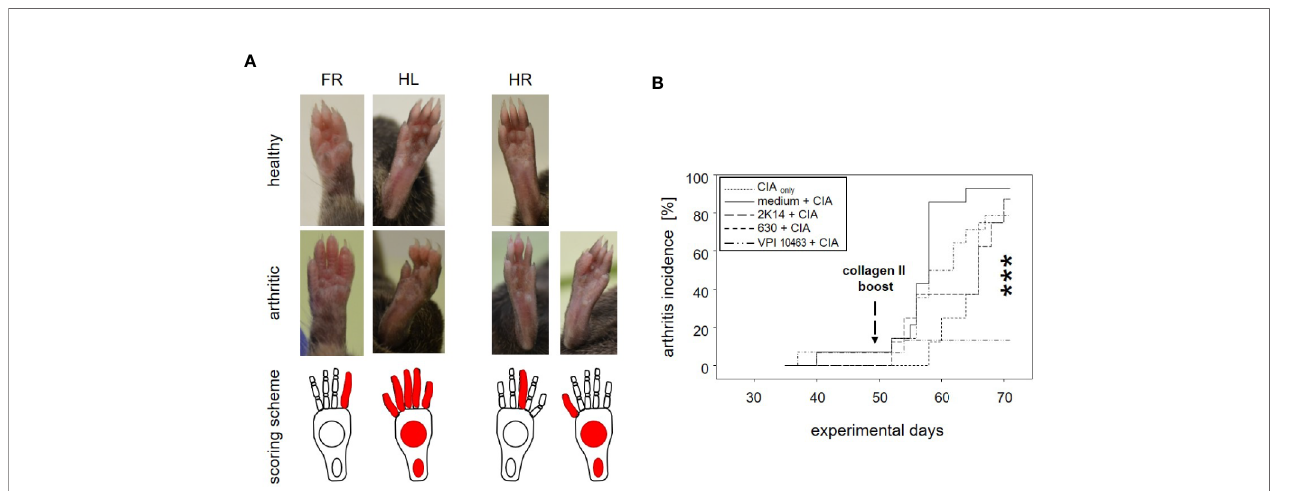
FIGURE 2 | Infection with Clostridioides dif fi cile signi fi cantly reduced incidence of collagen-induced arthritis in DBA/1J × B10.Q mice. (A) Macroscopic pictures of healthy (upper row) and arthritic paws (middle row) and corresponding scoring schemes (lower row) are shown. Middle row from left to right: an arthritis score of 1 (one in fl amed digit), 15 ( fi ve in fl amed digits, in fl amed tarsal and metatarsal joints), 1 (one in fl amed digit), and 11 (one in fl amed digit, in fl amed tarsal and metatarsal joints) respectively. (B) inverted Kaplan-Meier plot shows incidences of collagen-induced arthritis after mice were boosted on experimental day 49. Asterisks denote an extremely signi fi cant difference between the groups at the various time points as calculated via log rank (Mantel-Cox) test. The resulting p-value was